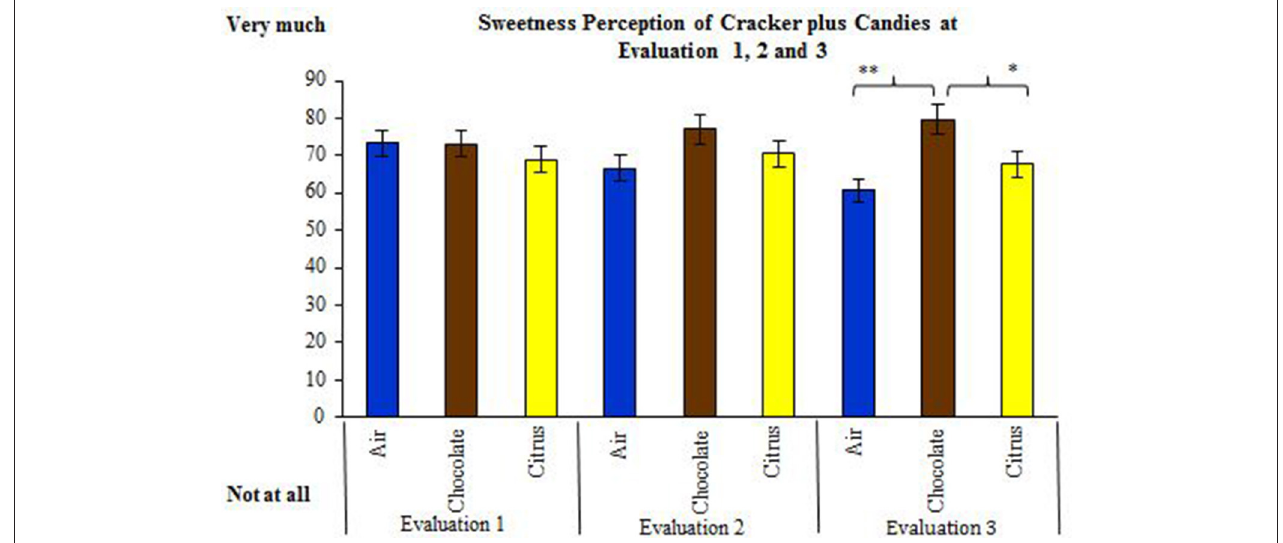
FIGURE 5 | The participants’ mean judgments of sweetness for both foods tasted as a function of the different odor conditions and of the evaluation sequence. Error bars represent the standard errors of the means. Asterisks represent Newman-Keuls significant differences at * p < 0.01 and ** p <